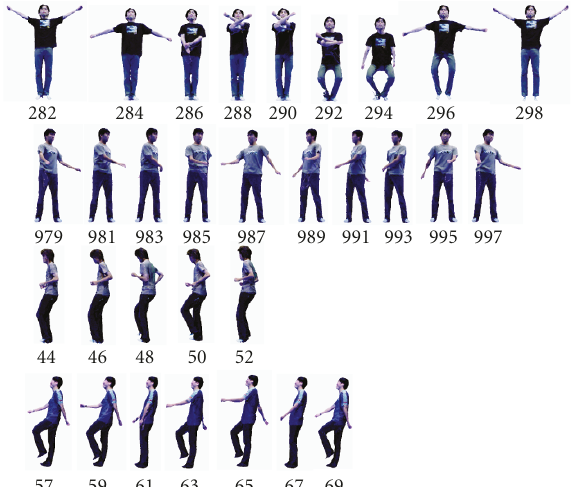
Figure 6: Samples of selected motion textons, only every two frames are shown for